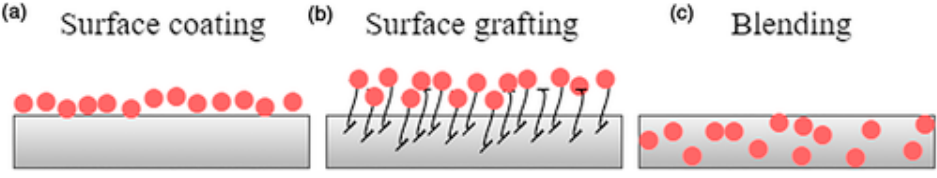
Figure 12. Schematic of different membrane modification techniques [223]. ( a ) surface coating; ( b ) surface grafting; ( c ) blending. Table 9. Research on material modification of polymeric membranes and their effects on oily wastewater cleaning from 2018 to present.